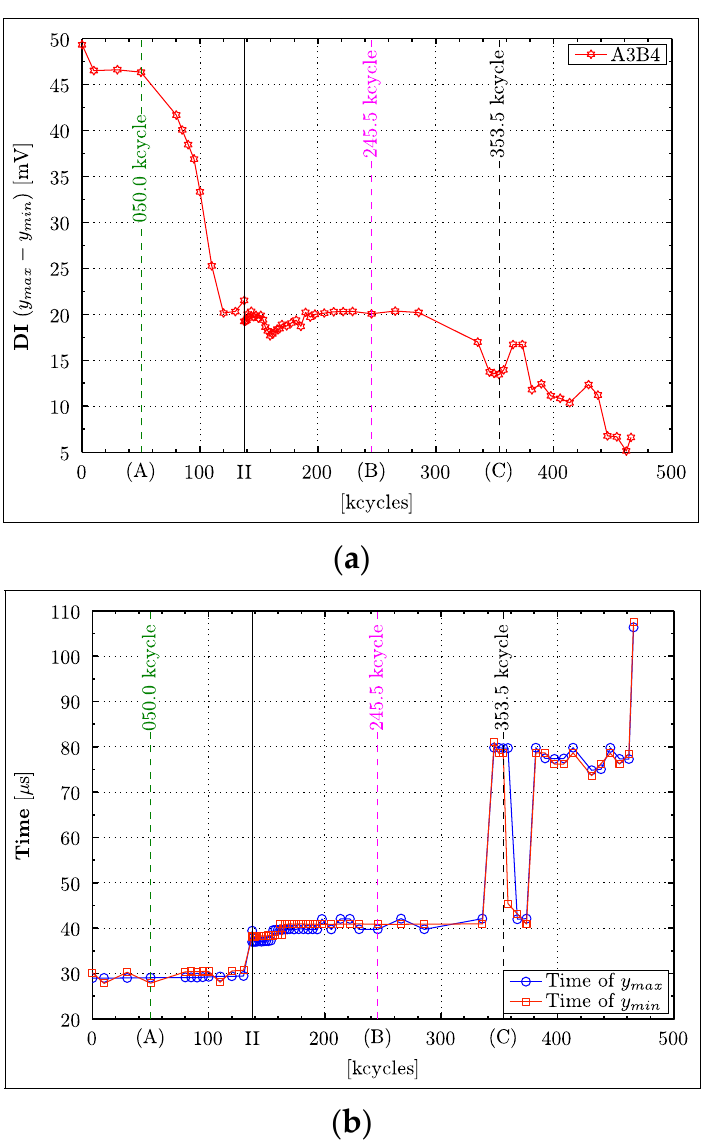
Figure 10. Extraction of peak-to-peak values for the A3B4 wave propagation path for consecutive fatigue cycles: ( a ) damage index based on the peak-to-peak value; ( b ) temporal location of respective maxima and minima used for peak-to-peak amplitude evaluation.